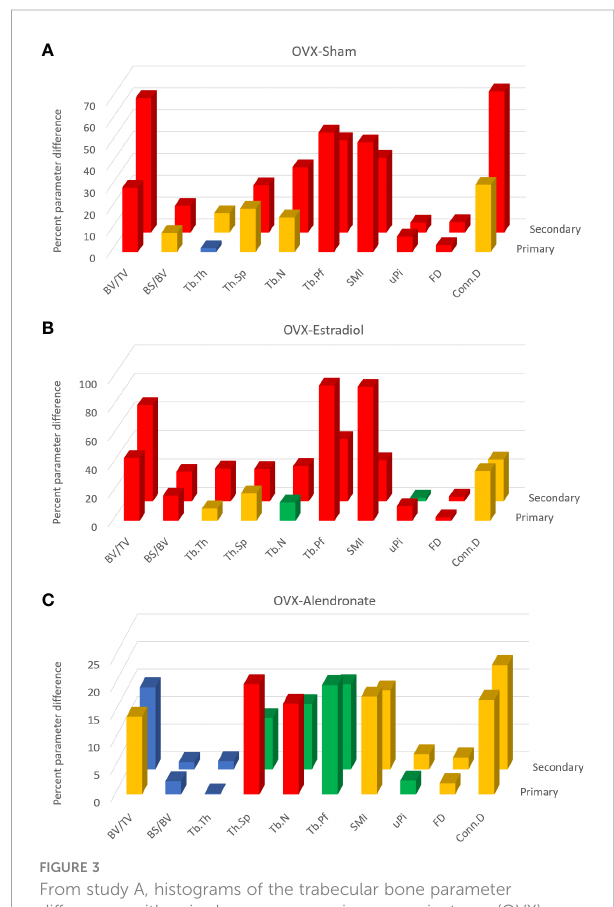
FIGURE 3 From study A, histograms of the trabecular bone parameter differences with paired-group comparisons: ovariectomy (OVX) – sham (A) , OVX – estradiol (B) , and OVX – alendronate (C) . The two rows of 3D columns show the data for the primary (front) and secondary (rear) spongiosal regions as labelled. ‘ Primary ’ refers to the 100 slices closest to the growth plate, while ‘ secondary ’ refers to the subsequent 400 slices from cross-section number 100 to 500 downstream. Note that the vertical y axis denotes not the parameter values per se but the percent difference thereof (made positive) between the paired groups. Colour coding of the parameter bars indicates statistical signi fi cance of difference according to Student ’ s T -test (two-tailed, heteroscedastic). Blue, p > 0.05; green, p < 0.05, p > 0.01; orange, p < 0.01, p > 0.001; red, p <